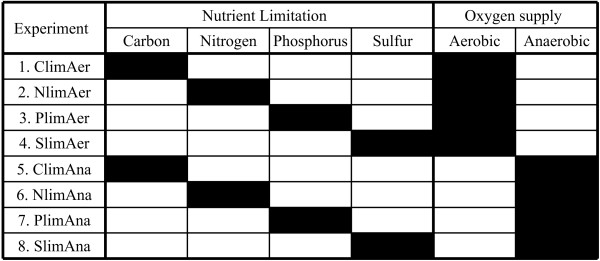
Schematic overview of the combinatorial cultivation conditions. Black squares indicate the employed nutrient limitation and oxygen supply.